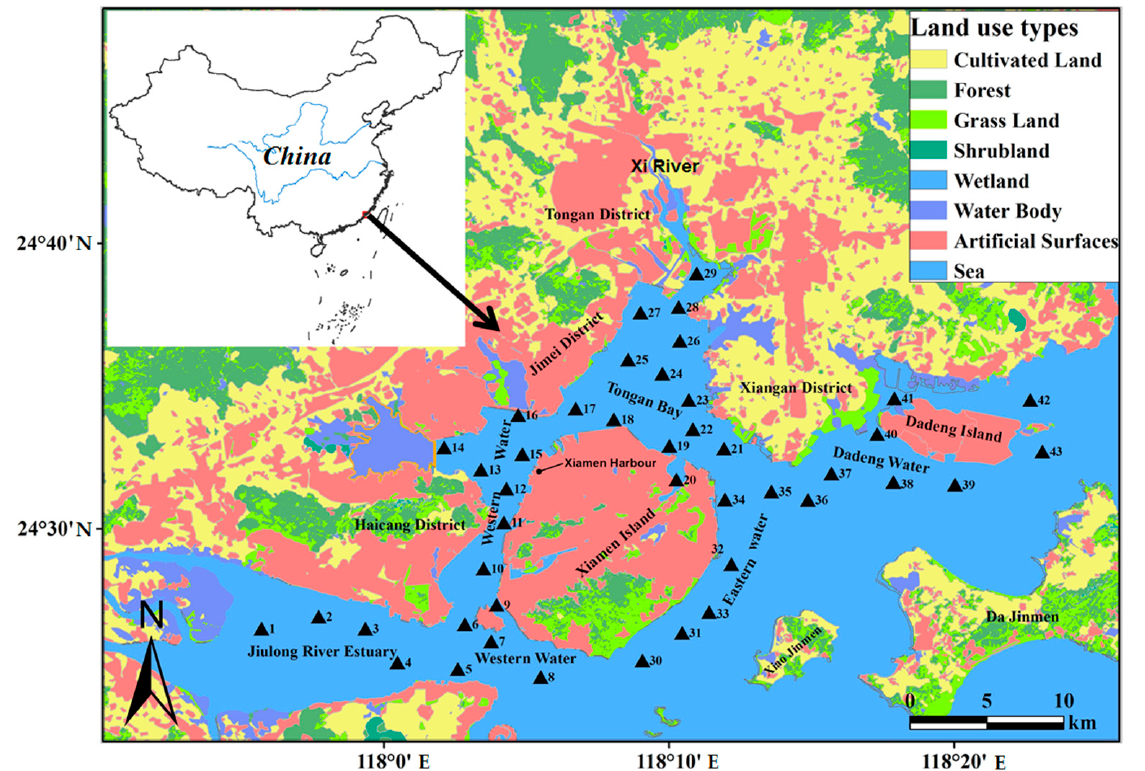
Figure 1. Sampling sites for surface sediments in Xiamen Bay ( ▲ : Sediment Sampling; 1–43: Station numbers).